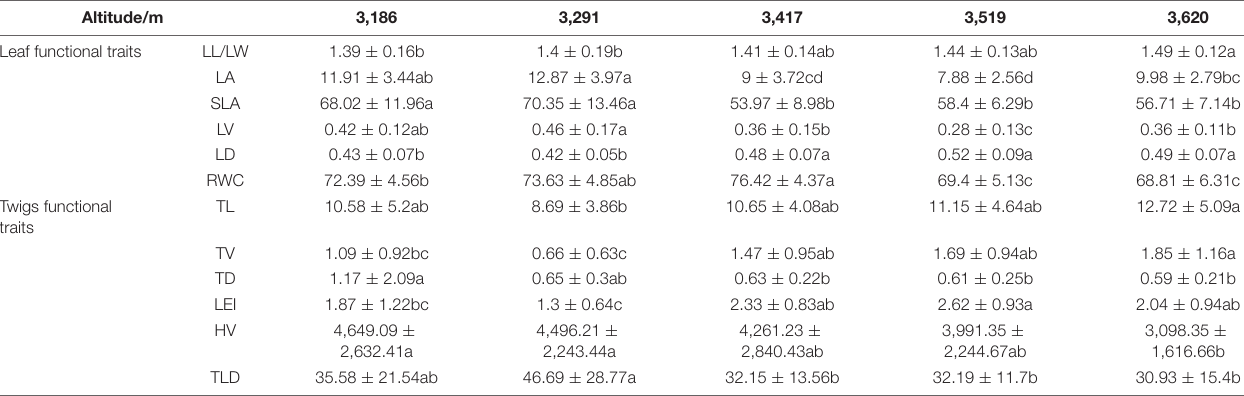
TABLE 3 | One-way analysis of variance of functional traits of Quercus aquifolioides between altitude. Altitude/m